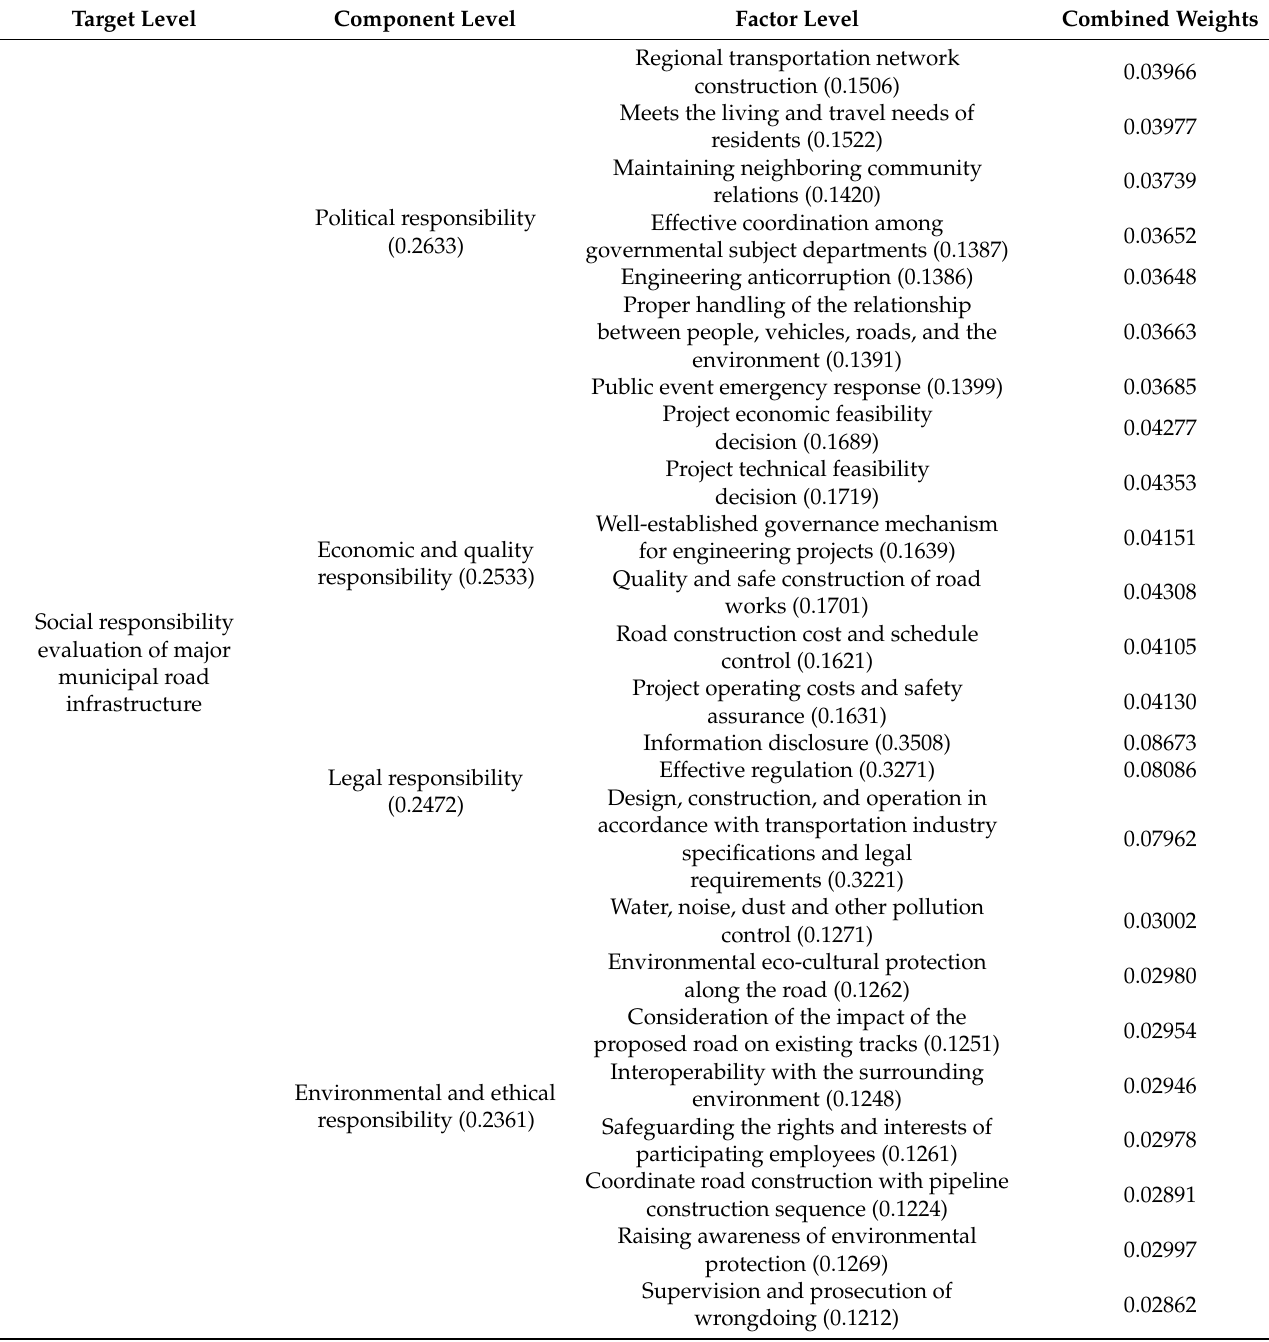
Table 3. Weight results for MMRISR indicator